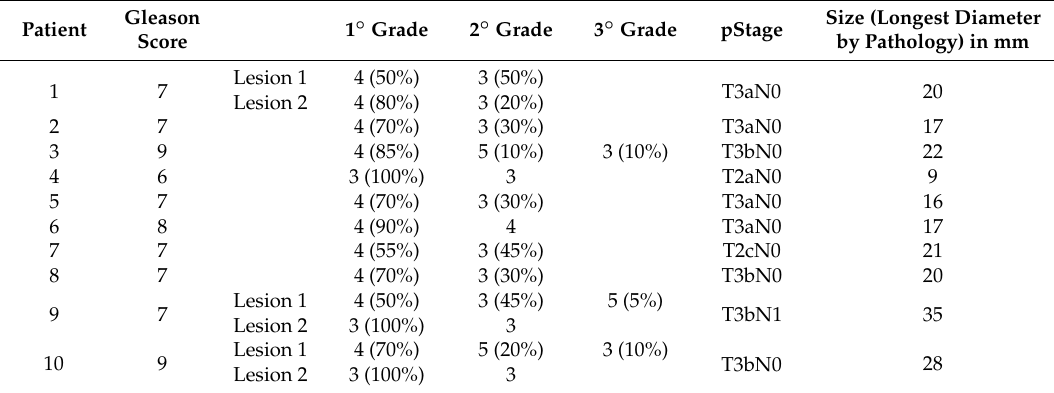
Table 1. Pathological tumor